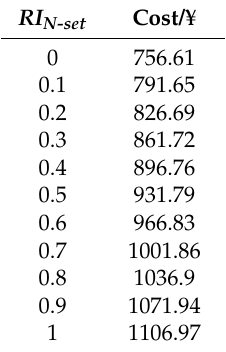
Table 4. Electricity cost under different robust indexes of the elevator system (down-peak mode).